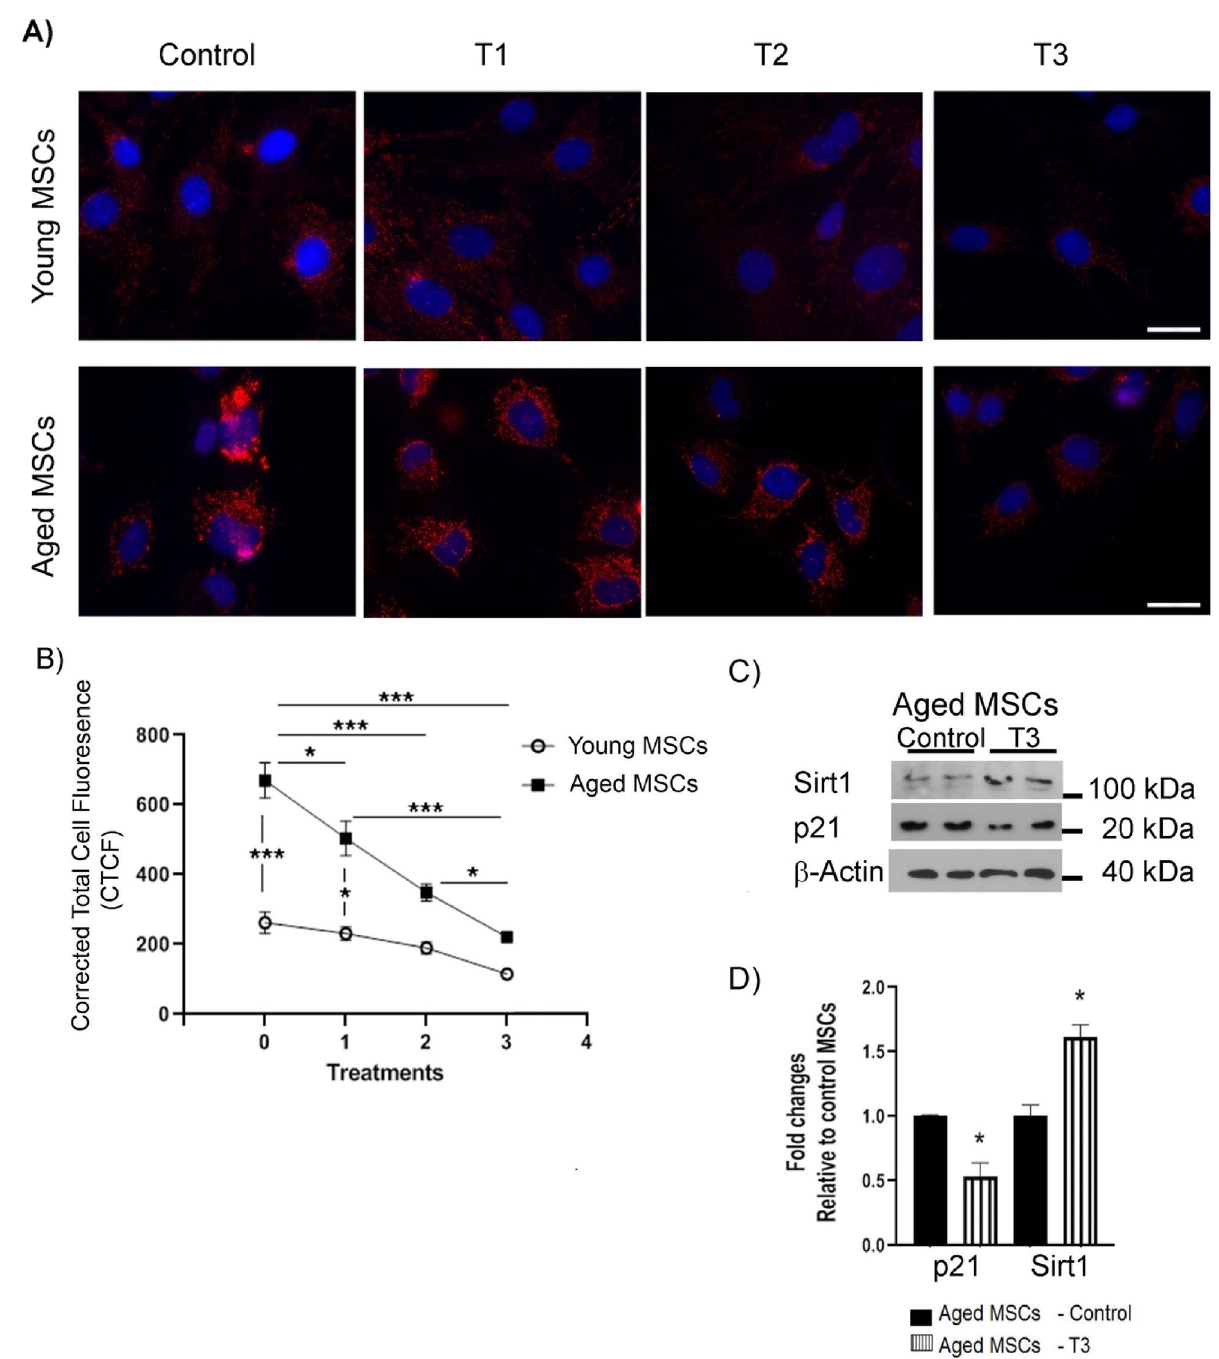
Figure 8. Effects of multiple doses of PBM on senescence marker levels of young and aged MSCs: Young and aged MSCs underwent a PBM treatment at 3 J/cm 2 for 1 (T1), 2 (T2) or 3 (T3) days in a row, while untreated MSCs served as controls. On day 7, the cells from both the control and experimental groups were harvested and subjected to either immunofluorescence staining or immunoblotting to evaluate their p21 and Sirt1 levels. ( A ) Shown are representative immunofluorescence images stained for p21 (red) and cell nuclei (blue). Scale bars: 20 μm. ( B ) Shown are corrected total cell fluorescence (CTCF) for each group after quantification of p21 fluorescence intensity using ImageJ. The error bars represent the standard error of mean. ( C ) Immunoblot analysis of p21 and Sirt1 in aged MSCs that were either treated with a 3-J/cm 2 fluence for 3 consecutive days (T3) or remained untreated (Control). β-actin was used as a loading control. ( D ) p21 and Sirt1 levels obtained by quantification of immunoblot bands and plotted as a bar graph, with significant differences indicated by asterisk signs. The bars represent means ± standard error of mean. * p < 0.05; *** p <